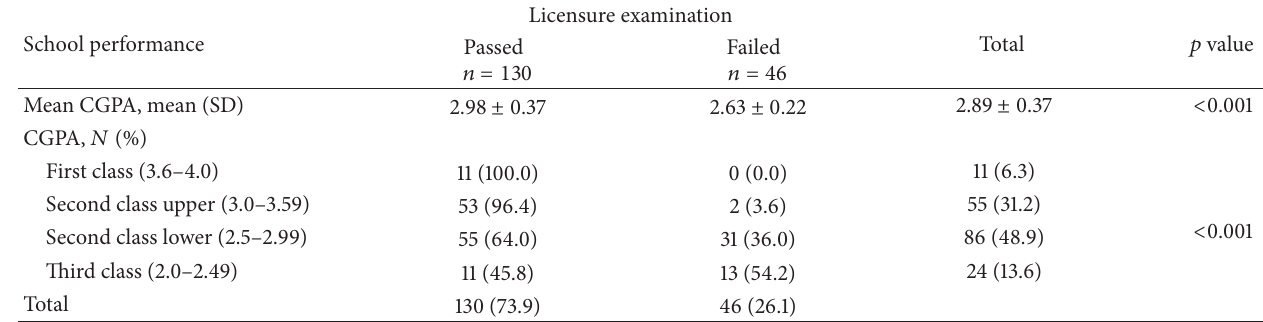
Table 2: Relationship between school performance and licensure